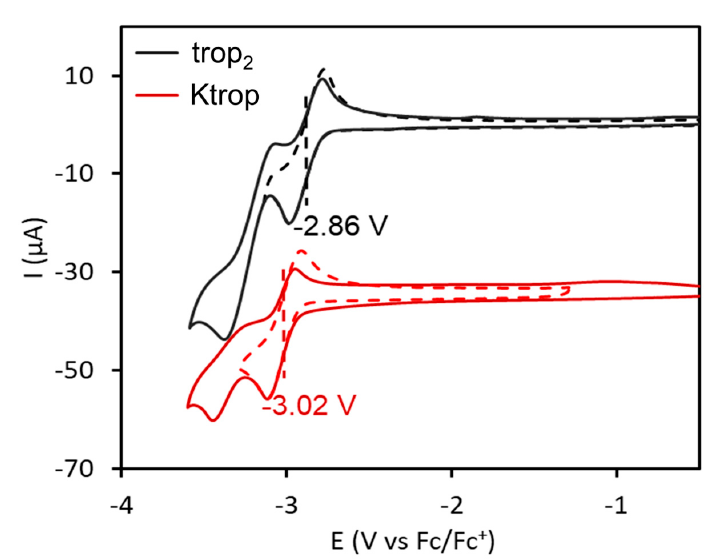
Figure 4. Cyclic voltammogram of trop 2 (1 mM) in dry tetrahydrofuran at ambient temperature with